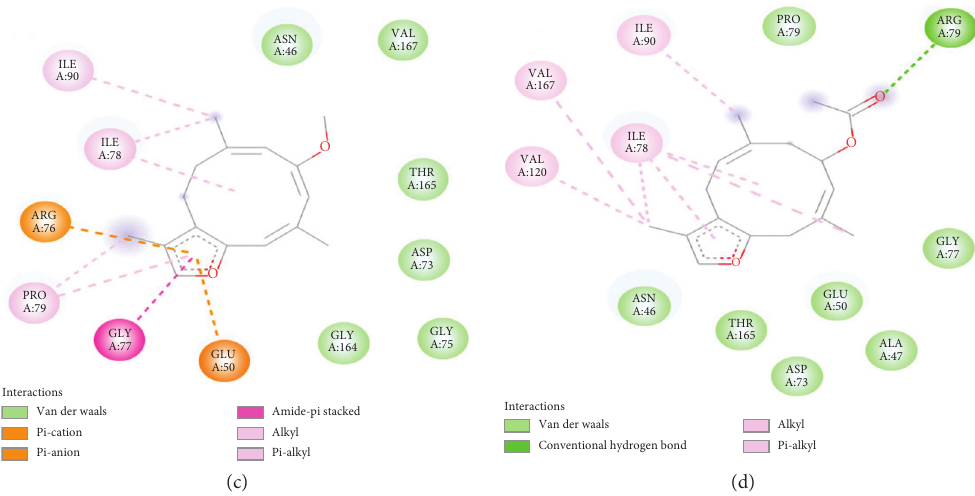
Figure 7: Molecular docking and interaction between DNA gyrase B and control ligand, CM-1 and CM-2. (a) Binding of control ligand (golden color), CM-1 (teal color), and CM-2 (green color) at the ATP binding domain of DNA gyrase B. Interaction between DNA gyrase B and control ligand (b), CM-1 (c), and CM-2 (d). Table 6: Molecular docking parameters for the interaction of CM-1 and CM-1 with the ATP binding domain of bacterial DNA Gyrase B. Donor-acceptor pair Distance (˚A) Nature of interaction Docking energy (kcal m − 1 ) Binding affinity, K d (m − 1 )